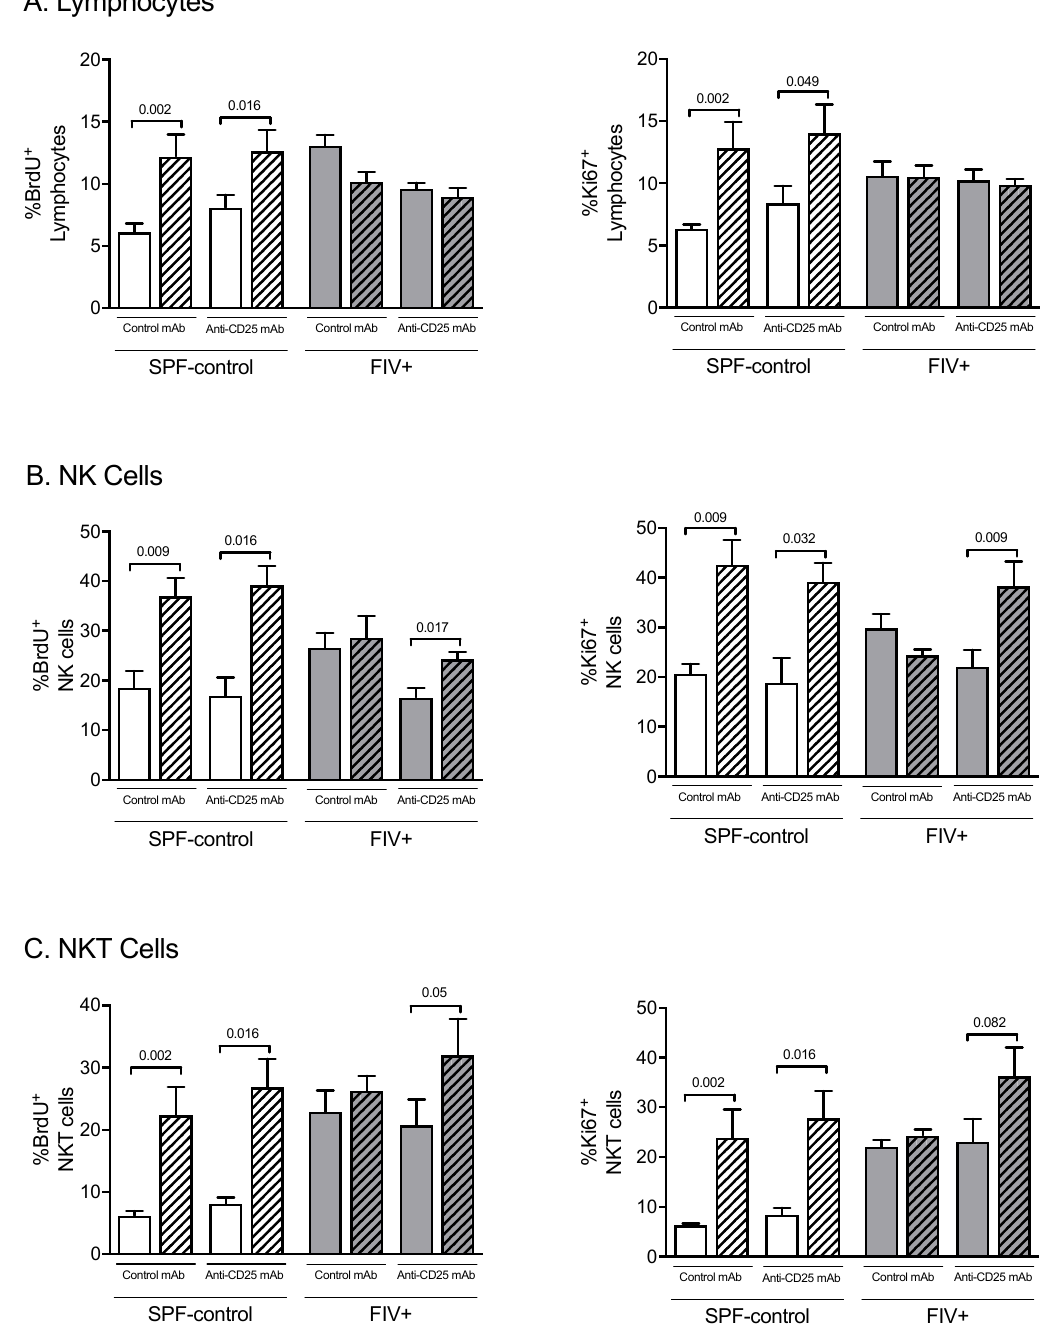
Figure 3. The effect of Treg depletion on NK cell and NKT cell proliferation. Cell proliferation was assessed in cats treated with isotype control mAb or anti-CD25 mAb by BrdU incorporation (left) or expression of the nuclear antigen Ki-67 (right). The percent of gated lymphocytes from the control lymph node (open bars) versus Lm-draining lymph node (hatched bars) that incorporated BrdU or expressed that Ki-67 was determined by flow cytometric analysis. ( A ) Percentage of proliferating total lymphocytes; ( B ) percentage of proliferating NK cells; ( C ) percentage of proliferating NKT cells. Statistical analysis was performed using one-way ANOVA with Tukey’s post-test; n = 6 for each treatment group; p - values are shown above brackets that indicate group comparisons.